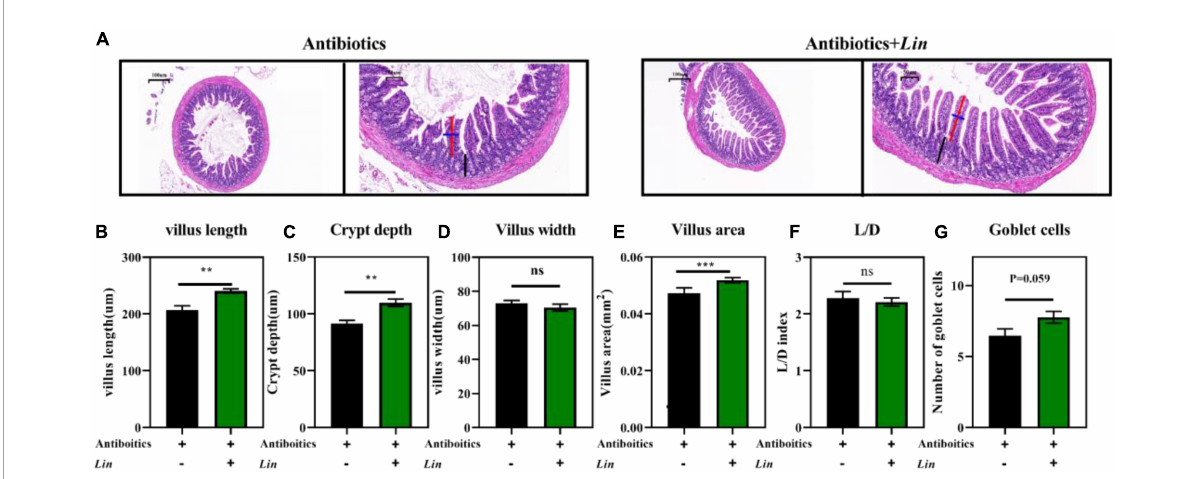
FIGURE7 Lactobacillus intestinalis colonization improved intestinal development in mice. HE staining the ileum (A) , villus length in the ileum (B) , villus width in the ileum (C) , villus areas in the ileum (D) , crypt depth in the ileum (E) , L/D in the ileum (F) , and the number of goblet cells (G) ( n = 10). Differences were assessed by t -test and denoted as follows: ** P < 0.01, *** P < 0.001.